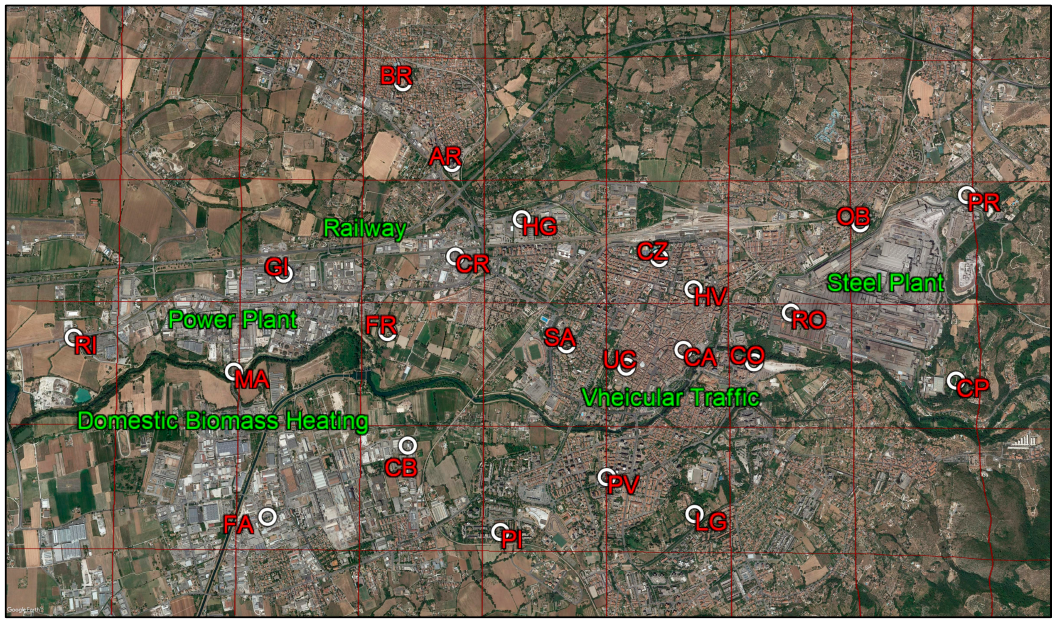
Figure 1. Map of monitoring sites of Terni (Google Earth Pro) with the particulate matter dispersion grid and the main local emission sources represented.